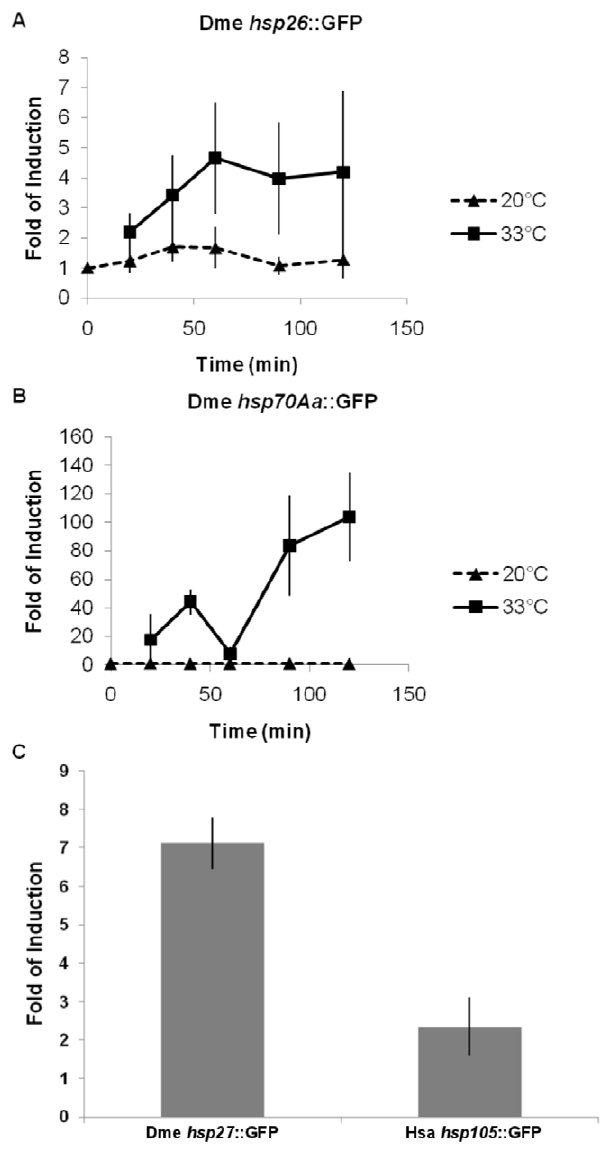
Figure 1. Induction of promoters of Drosophila and human heat-shock genes in C. elegans . A) Worms carrying reporter transgenes were heat shocked at 33 u C for the indicated periods of time. The mRNA level was measured by quantitative RT-PCR. Each data point represents 3 independent biological replicates (with standard error). B) Same as in A), except each data point represents 2 independent biological replicates. C) Worms carrying reporter trans- genes were heat shocked at 35 u C, and 30–40 minutes later the mRNA level were measured by quantitative RT-PCR in 2 independent biological